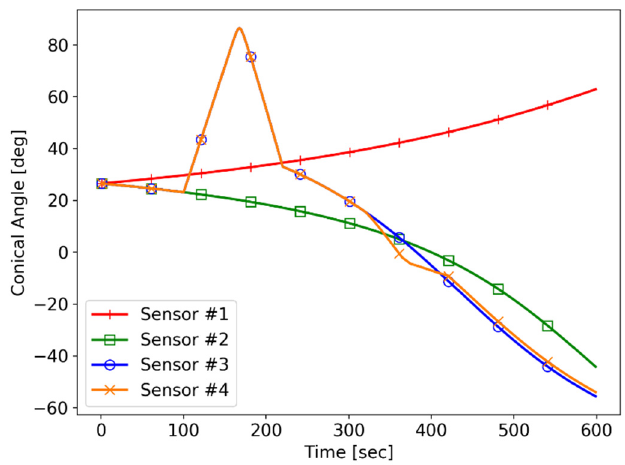
Figure 9. Simulation I: conic angle trajectories.